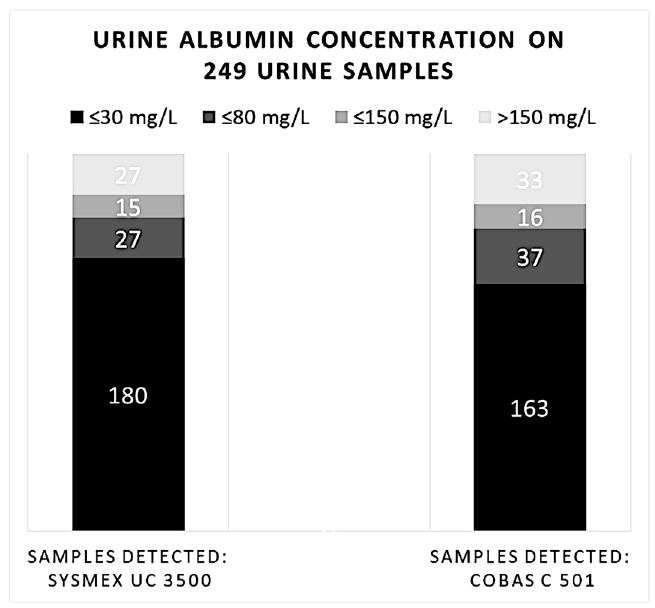
Figure 2. Comparison of 249 samples of albuminuria calculated using the semi-quantitative and quantitative methods and categorized on MEDITAPE UC-11A ranges (mg/L).